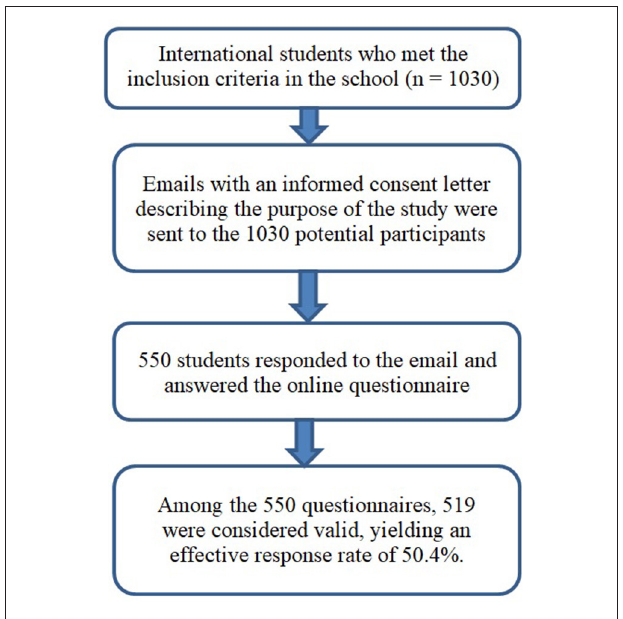
FIGURE 1 | Flow chart of the data collection